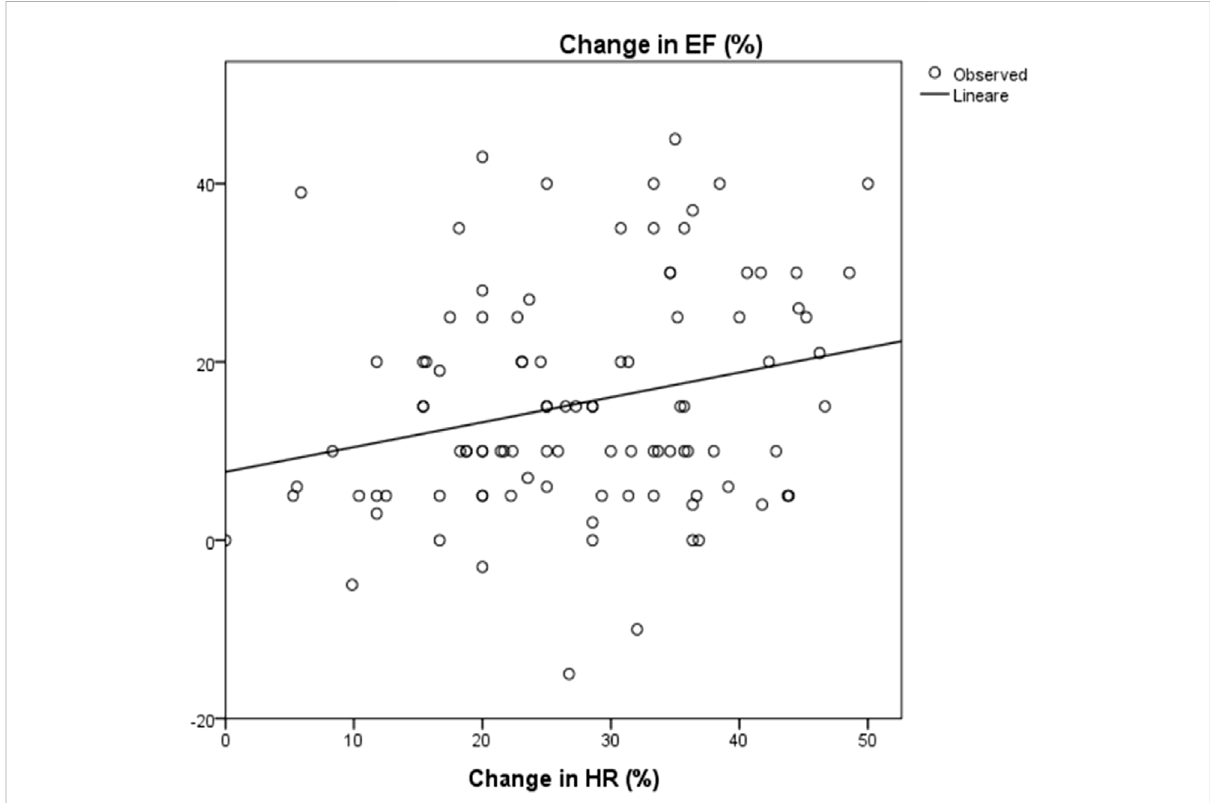
FIGURE 4 Correlation between change in HR and change in EF: R2 0.06; p = 0.014. HR: Heart rate; EF: Ejection Fraction. The change in ejection fraction wascalculatedbetweenEFatbaselineandafter3 yearsoffollowup.ThechangeinHRwascalculatedasthedifferencesbetweenbaselineandatthe maximum dose of